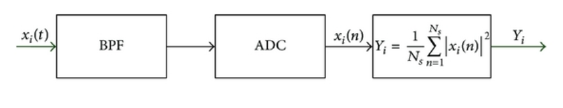
Figure 2. Functional diagram of Energy